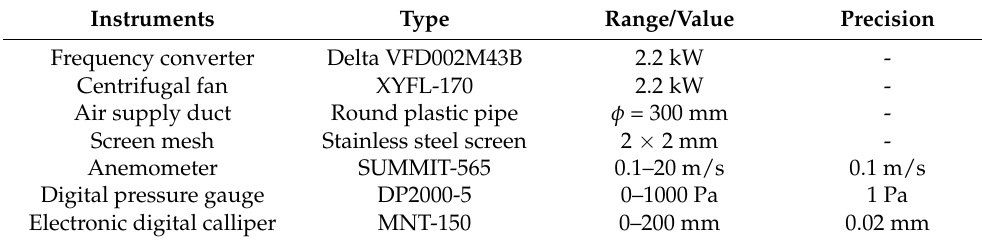
Table 2. In order to develop the mathematical relations between the independent